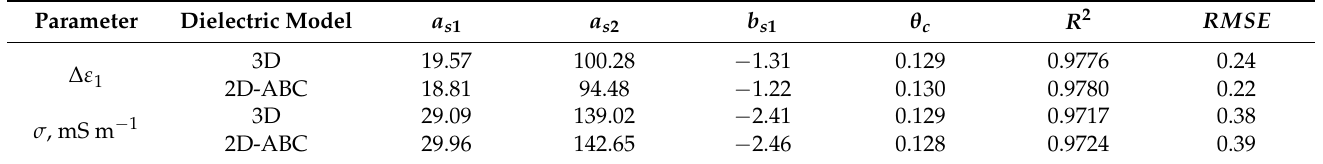
Table 4. Parameters of the segmented model (Equation (10)) fitted to the ∆ ε 1 ( θ ) and σ ( θ ) relations, with ∆ ε 1 and σ obtained with the use of 3D and 2D-ABC dielectric